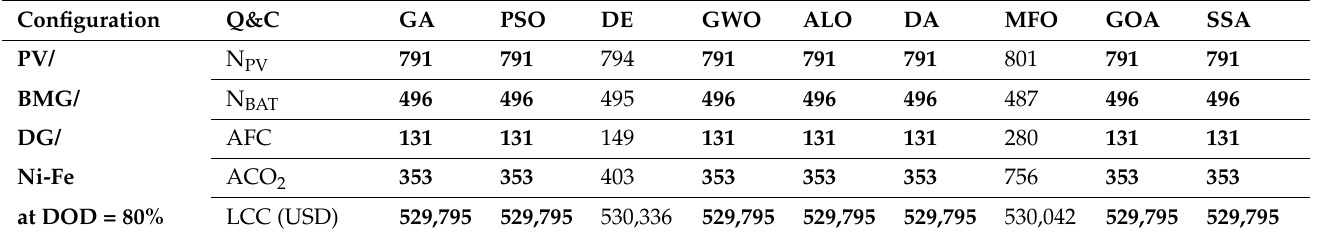
Table 13. Optimization results of the LPRAHC-based IHRES using CC strategy at LPSP value of